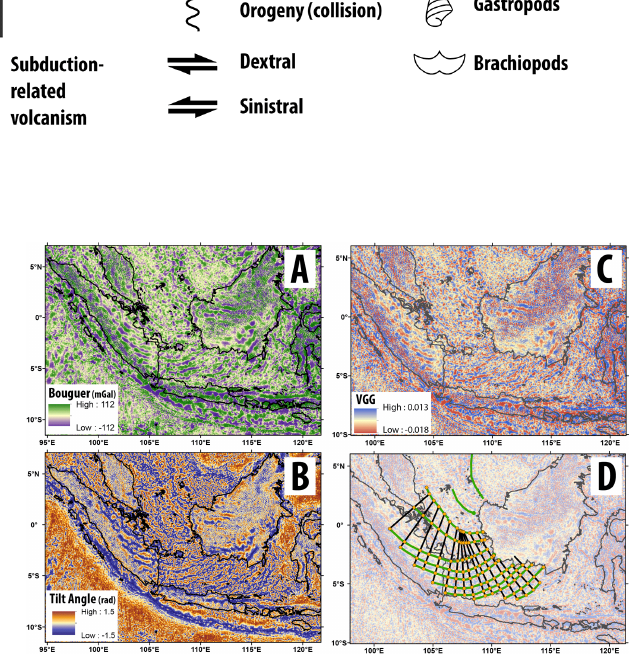
Fig. 4. Band-pass-filtered (150 to 10km) Bouguer gravity anoma- lies (A) from the 1min World Gravity Map (Balmino et al., 2012) highlight the large-scale structures and the curved lineaments on Sundaland, resulting from oroclinal bending as proposed by Hutchi- son (2010). Bouguer gravity tilt angle derivatives (B) and vertical gravity gradients (C) were derived from the Bouguer anomalies and were also band-pass-filtered (150 to 10km) to remove noise from small-scale structures. The vertical gravity gradient was used as a guide to digitize the curved lineaments on Sundaland (green, D ). The Cretaceous Woyla, Luk-Ulo and Meratus sutures, along with the Paleozoic Bentong–Raub suture, retain a strong signature of a lithospheric-scale discontinuity. Conversely, the Billiton De- pression is not observable as a generally north–south cross-cutting lithospheric-scale heterogeneity, and instead is likely to be a bathy- metric anomaly related to rifting in the West and East Natuna